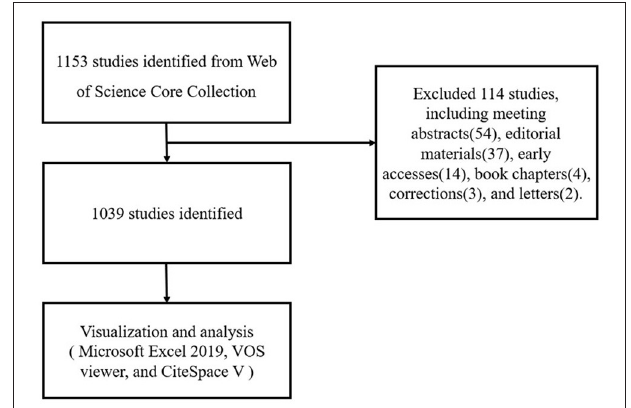
FIGURE 1 | Flowchart of literature